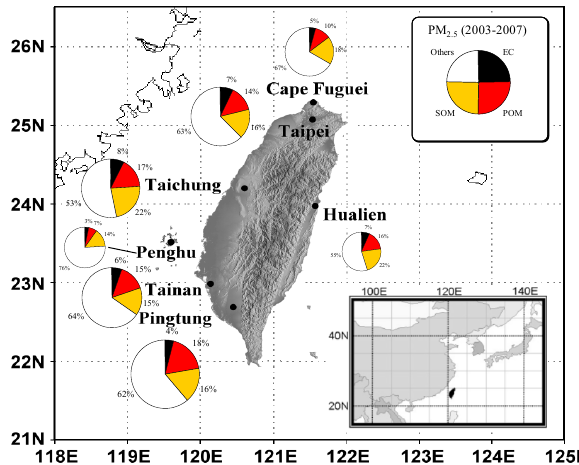
Fig. 5. Same as Fig. 4 but for PM 2 . 5